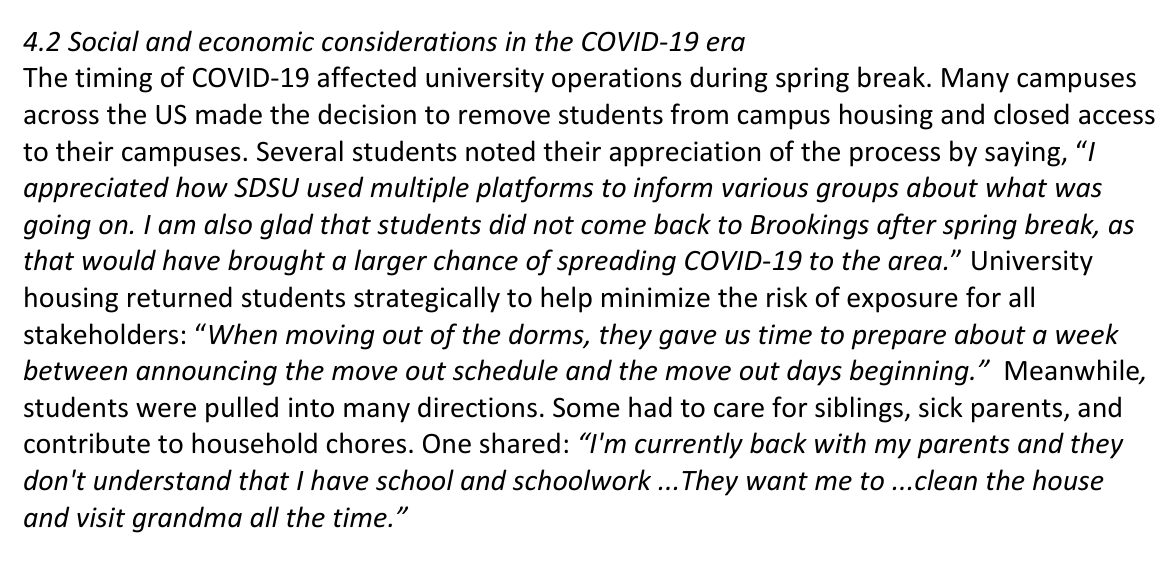
Figure 4: Student reflection on SDSU’s response to